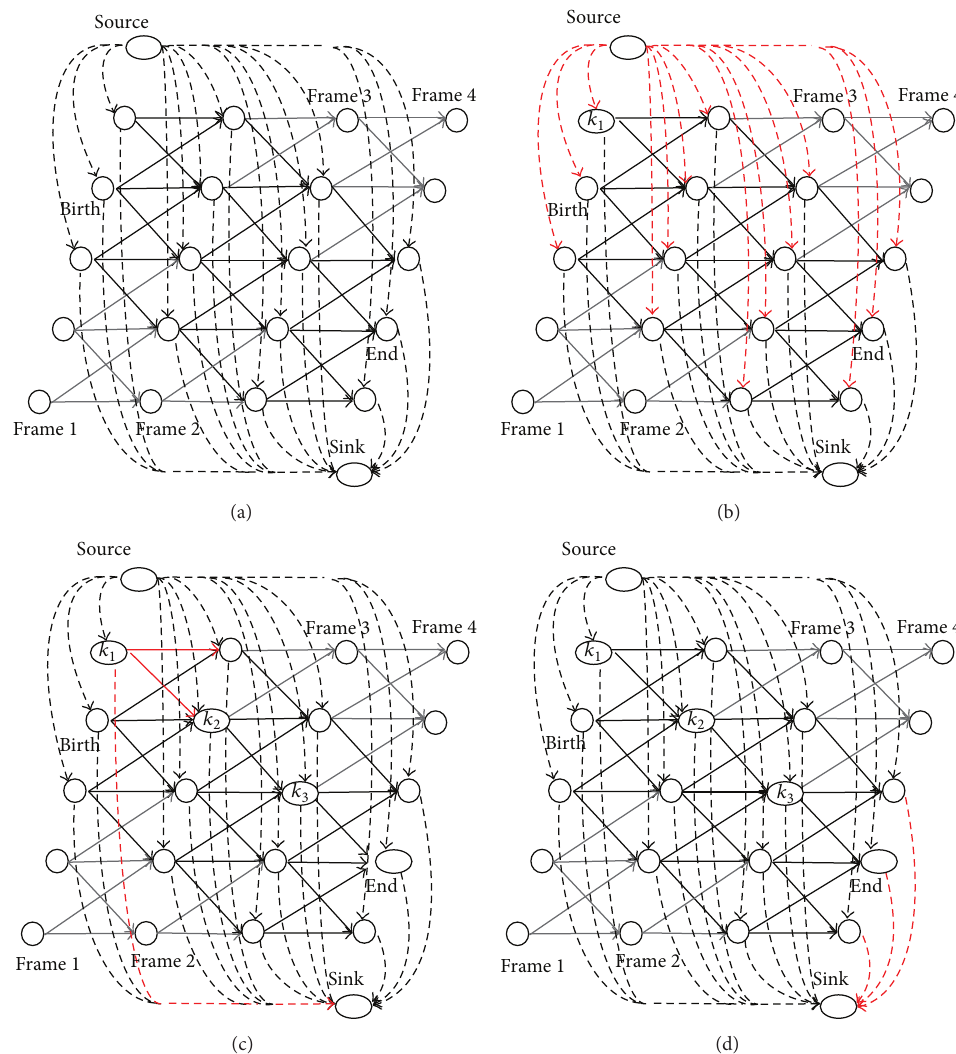
Figure 2: The shortest path faster algorithm. (a) Recording all nodes of 𝐺 𝑟 in an adjacency list, starting from the source node. Adding the source into the queue 𝑄 , let 𝐷( source ) = 0 ; (b) adding all the nodes that can be reached from source to 𝑄 and recording the cost values in 𝐷 . (c) Adding all nodes that can be reached from 𝑘 1 to 𝑄 and recording their total cost values. If a node has been in queue 𝑄 , update its total cost value to the smaller value in 𝐷 ; (d) iterating (c) until queue 𝑄 is empty and the shortest path 𝑇 = (𝑘 1 ,...,𝑘 𝑁 ), 𝑘 𝑁 ∈ 𝐺 𝑟 from source to sink can be obtained at the same time. Legend: black solid line, all edges among positions that can be reached, red solid line, all edges from the current position to potential locations that can be reached, black dashed line, all edges between virtual positions and the potential locations that can be reached, and red dashed line, all edges from the current position (or virtual positions) to virtual positions (or potential locations) that can be